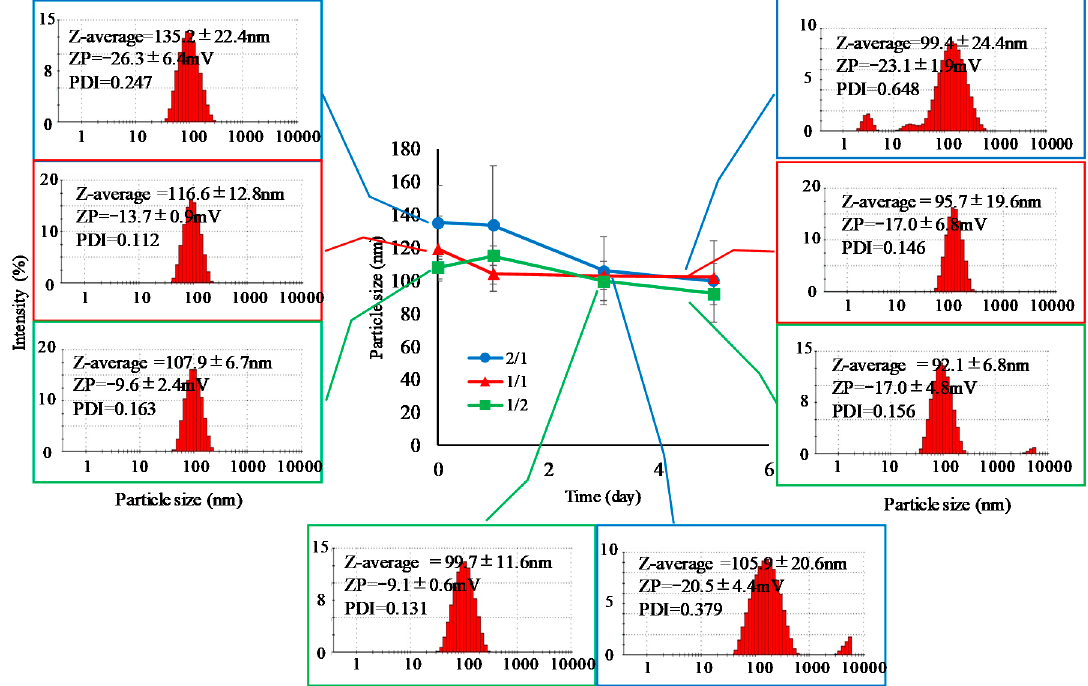
Figure 4. Changes in particle size and zeta potential of nanoparticles of DSPE-PEG2000/Soluplus = 2/1, 1/1, 1/2 nanoparticles after the storage at 25 °C day 0 to day 5.